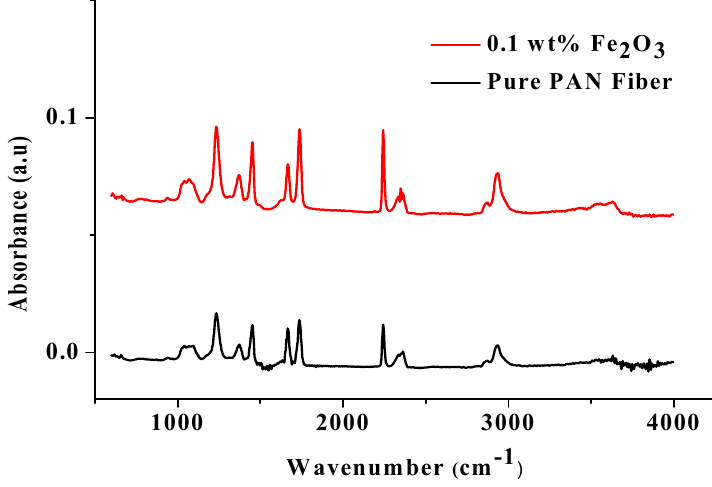
Fig. 5. FT-IR spectra of pure PAN fibers and PAN/Fe 2 O 3 nanocomposite fibers with 1 wt% Fe 2 O 3 nanoparticle